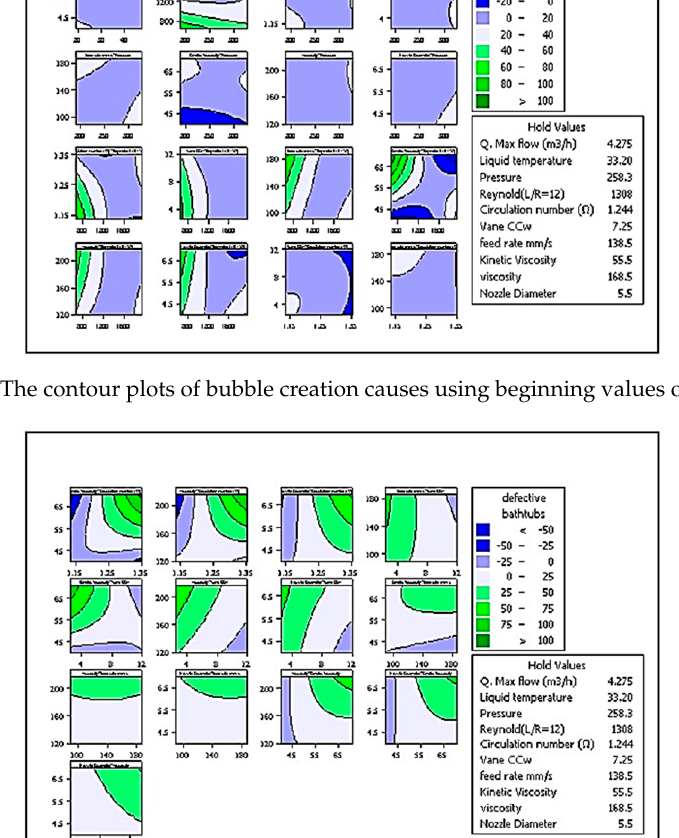
Figure 25. The contour plots of defective causes using beginning values of NN runs.